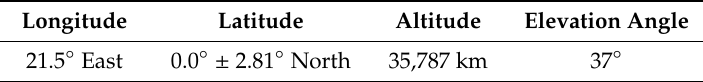
Table 1. ARTEMIS location parameters.